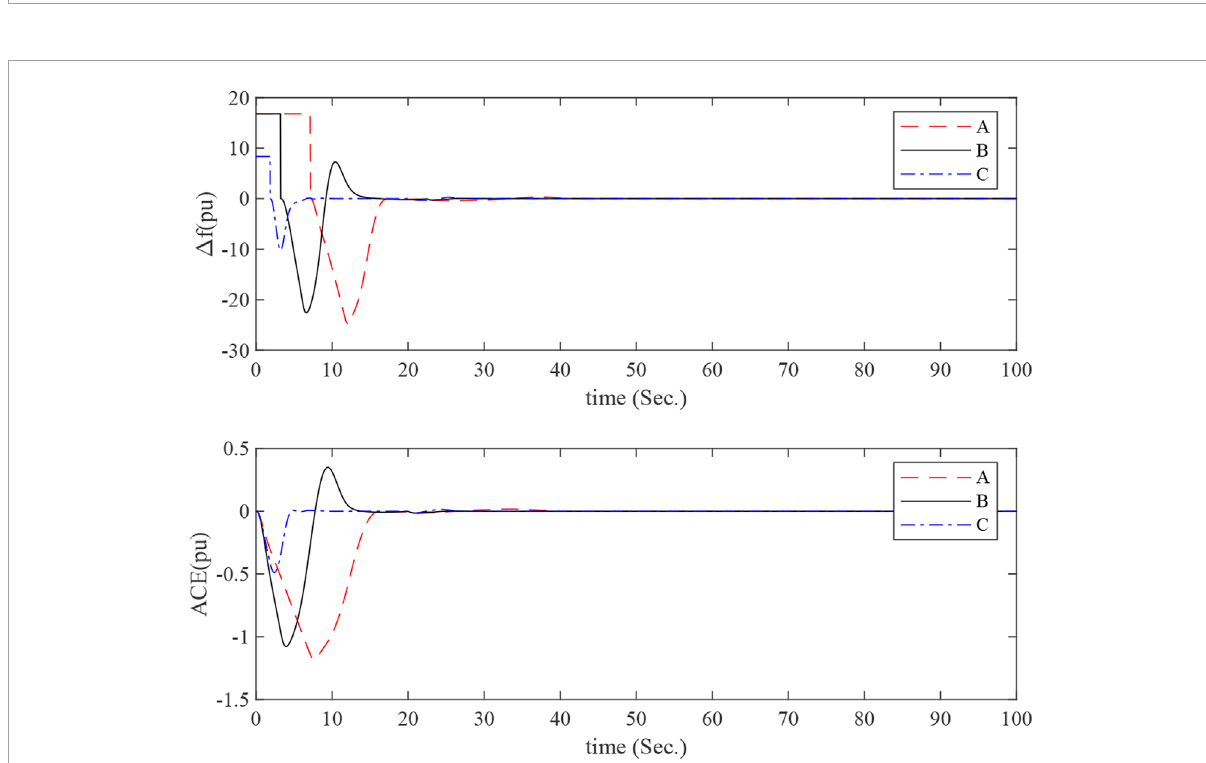
FIGURE 3 Frequency deviation and control error responses of the one-area LFC power system with K P = 0 . 1 and different K I